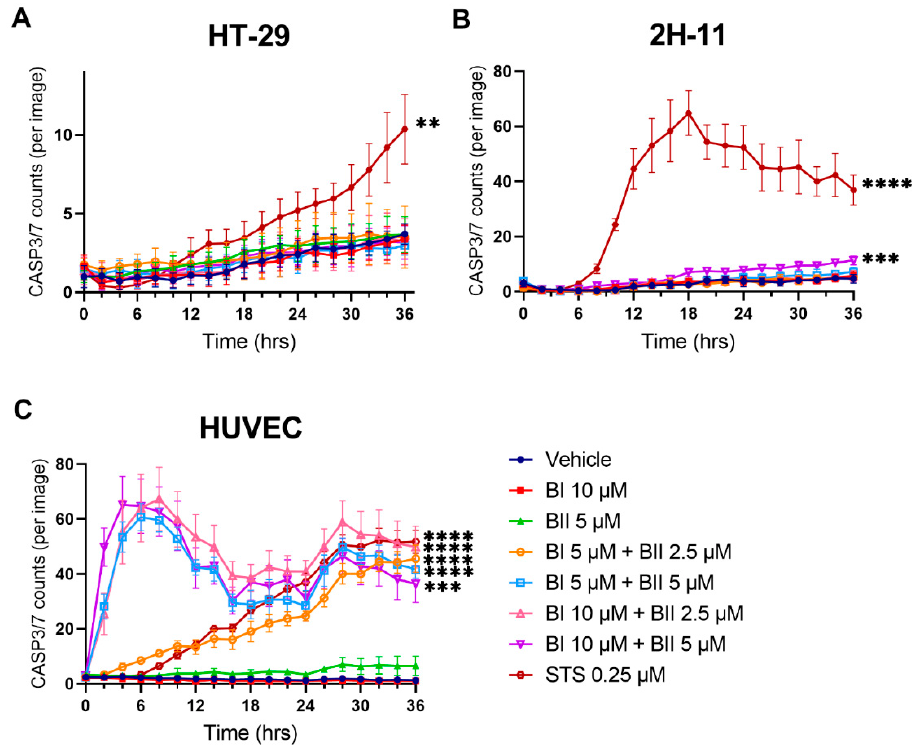
Figure 5. Bac I and II combined induced caspase 3/7 activation in HUVEC, but not in HT-29. HT-29 ( A ), 2H-11 ( B ) and HUVEC ( C ) were treated with bac I and II, either alone or in combination, and caspase 3/7 activation was monitored using CellEvent Caspase-3/7 Green Detection Reagent. Data represent the mean number of caspase 3/7-positive cells per image for 6 replicates. Error bars represent the SD. A significant difference at 36 h as compared to the vehicle is indicated by asterisks (** p < 0.01; *** p < 0.001 **** p < 0.0001).